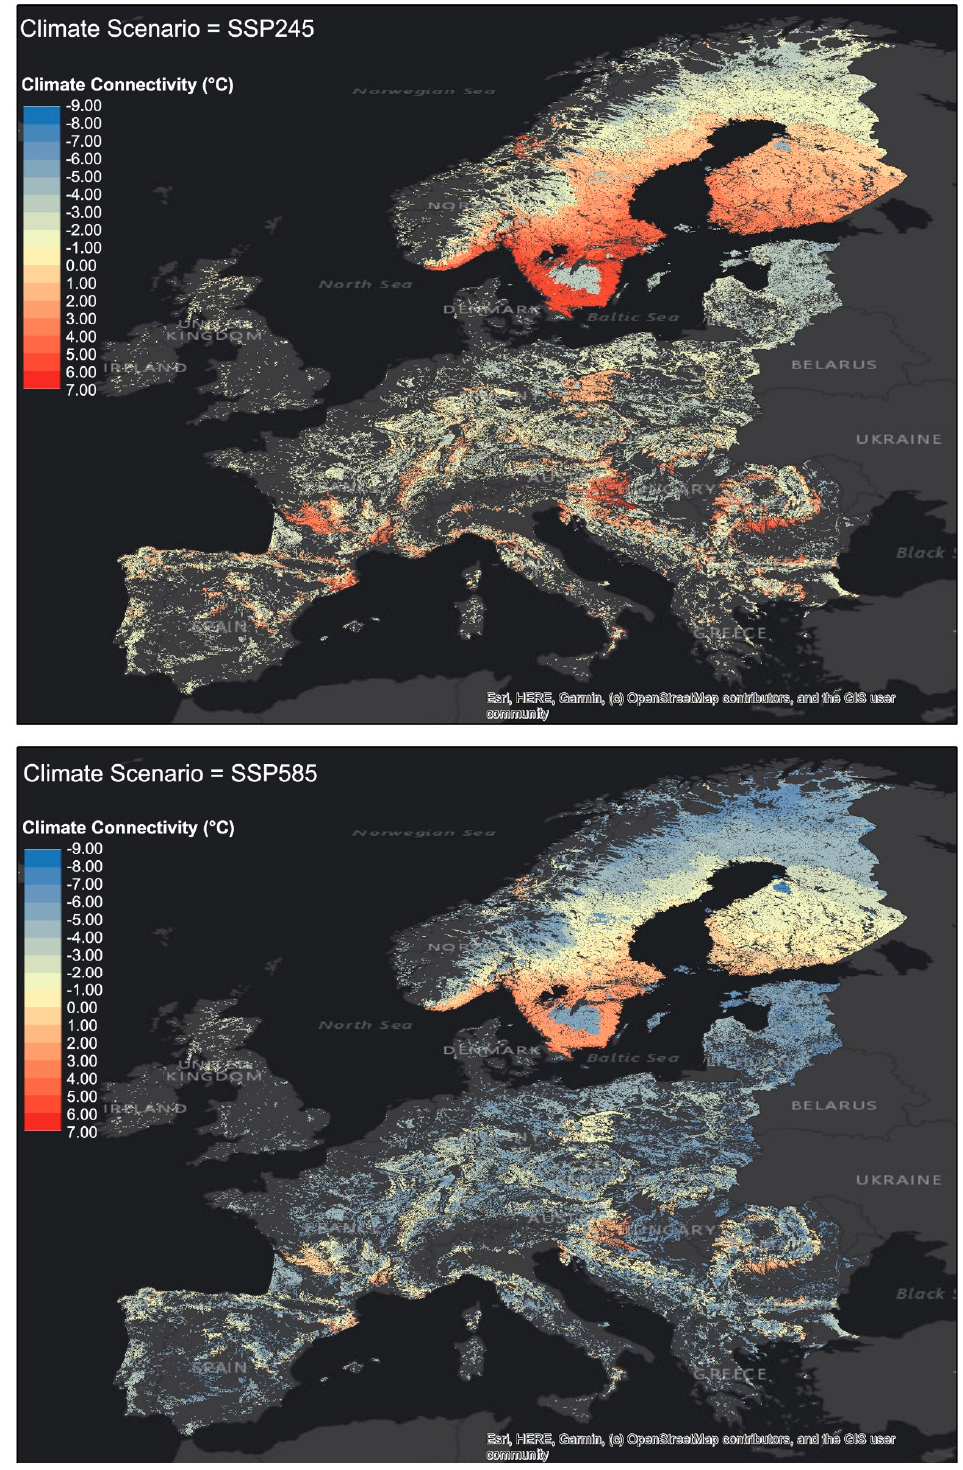
Figure 2. Maps of climate connectivity under the moderate (SSP245) and the most severe (SSP585) climate scenarios.